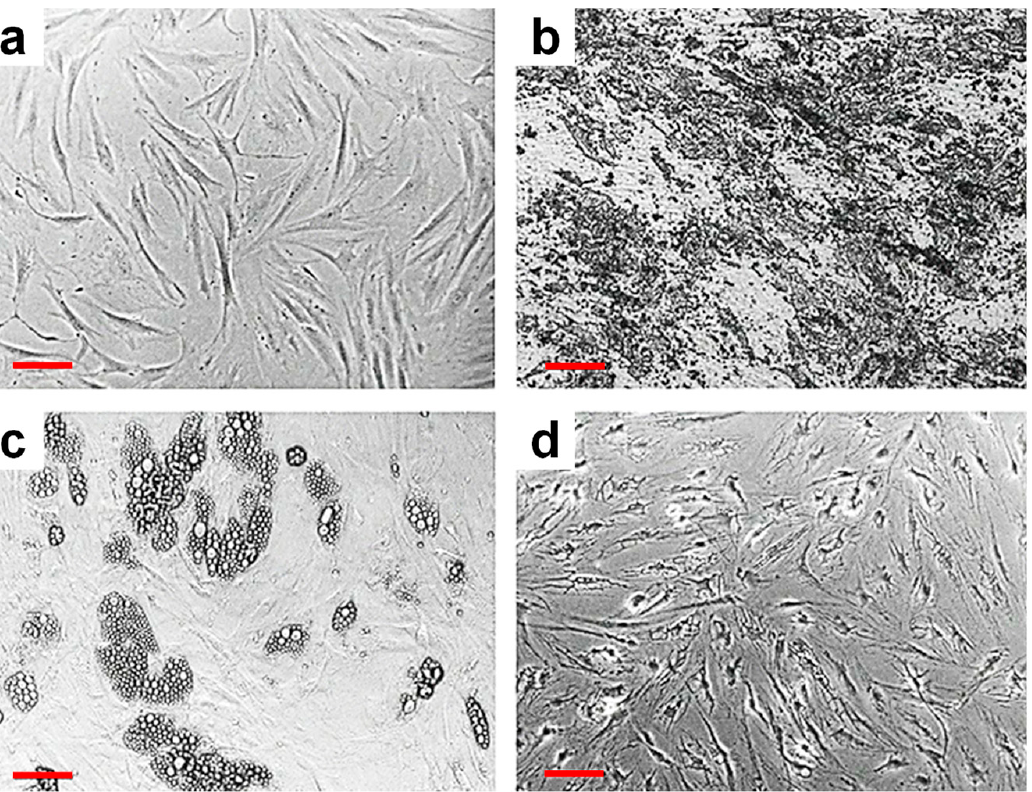
Figure 3. Human adipose MSCs undifferentiated cells ( a ) suffering osteogenic ( b ), adipogenic ( c ) and neurogenic ( d ) differentiation, respectively. Scale bars in red represent 100 µ m. Adapted with permission from ref. [96].